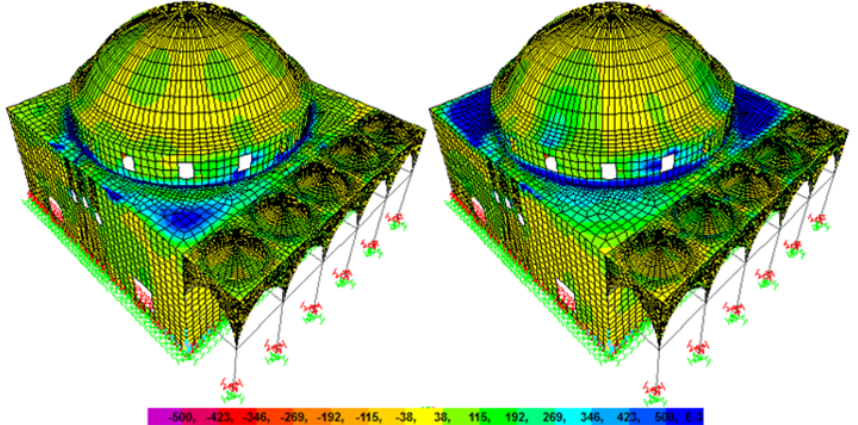
Figure 16. Maximum shear stresses contour diagram for the outer and inner surfaces of the mosque with 16 window openings under dead load and earthquake load (G +